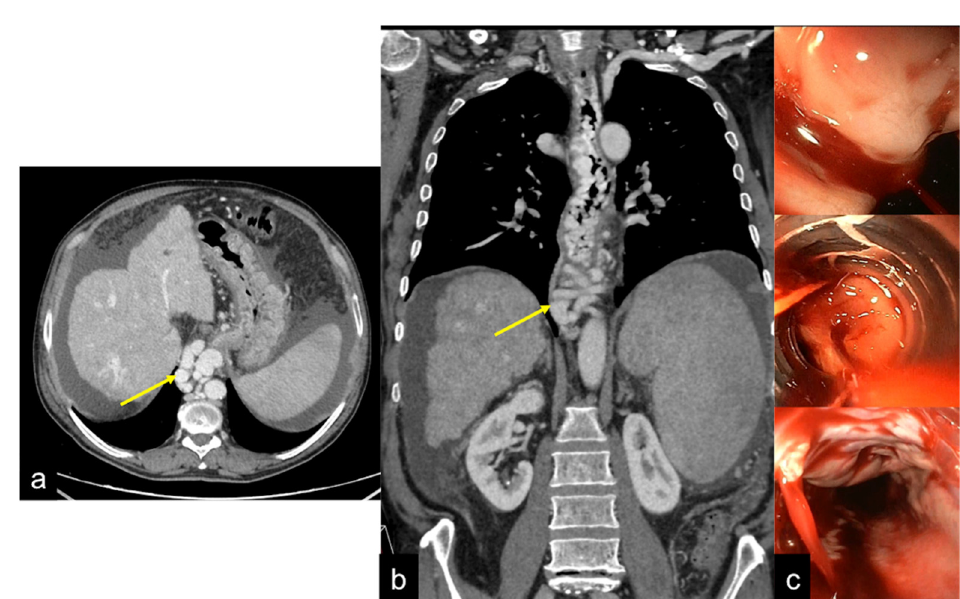
Figure 21. Axial ( a ) and coronal ( b ) images of CTA multiphasic study with endoscopic corresponding images ( c ). In CT, the oesophageal varices in portal hypertension are visualised as tubular structures with an endoluminal protrusion in the oesophageal wall (( a , b ) arrow); the endoscopic evaluation reveals signs of active bleeding ( c